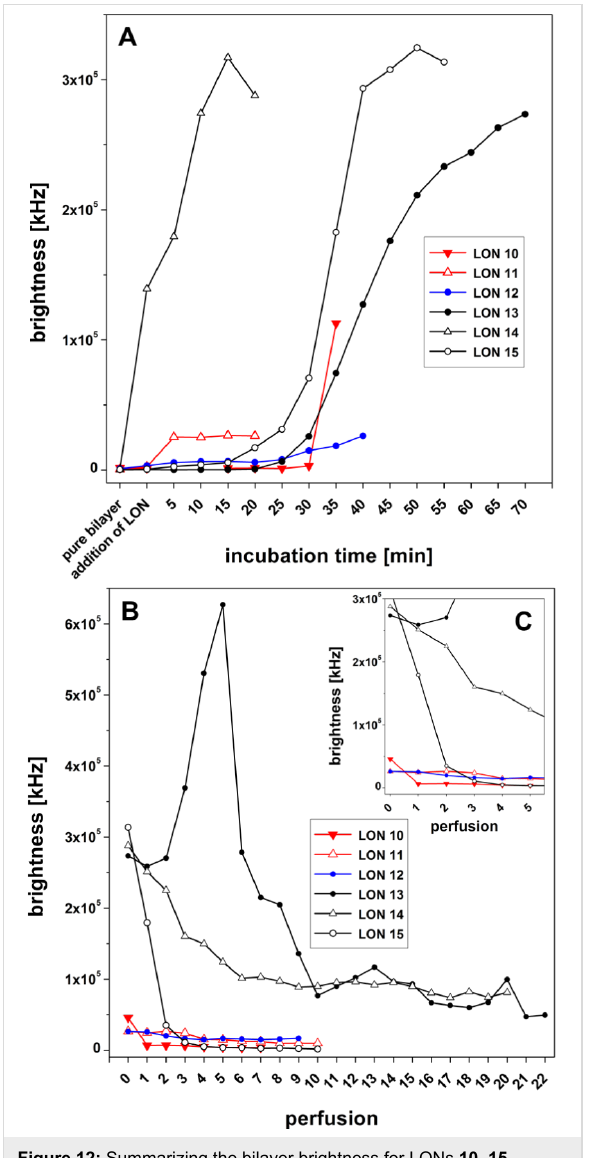
Figure 12: Summarizing the bilayer brightness for LONs 10–15 depending on the incubation time up to the maximum brightness (A), as well as on the number of perfusions (B) with details shown in (C).